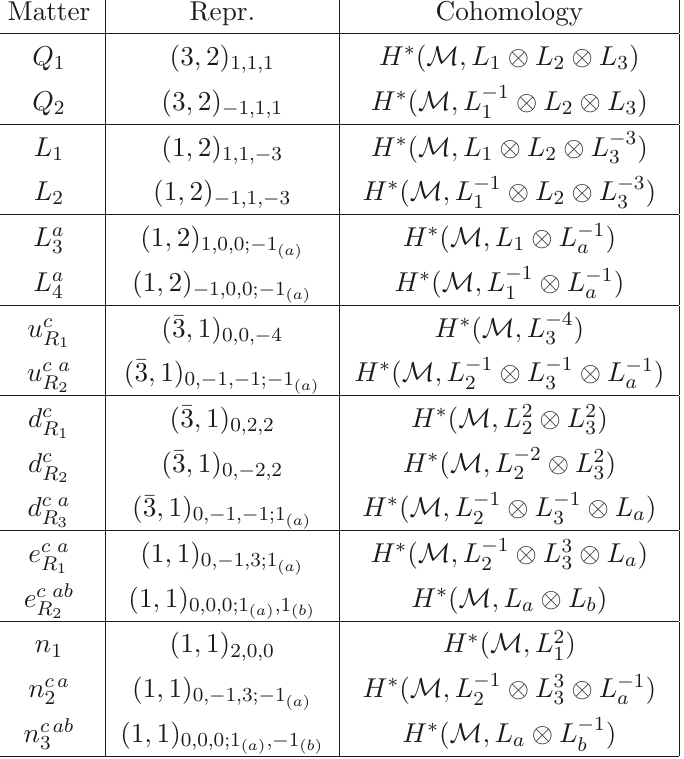
where ˆ w i are the Hodge dual four-forms of the K¨ahler forms w i and vol 6 denotes the volume form of the CY manifold, b (0)